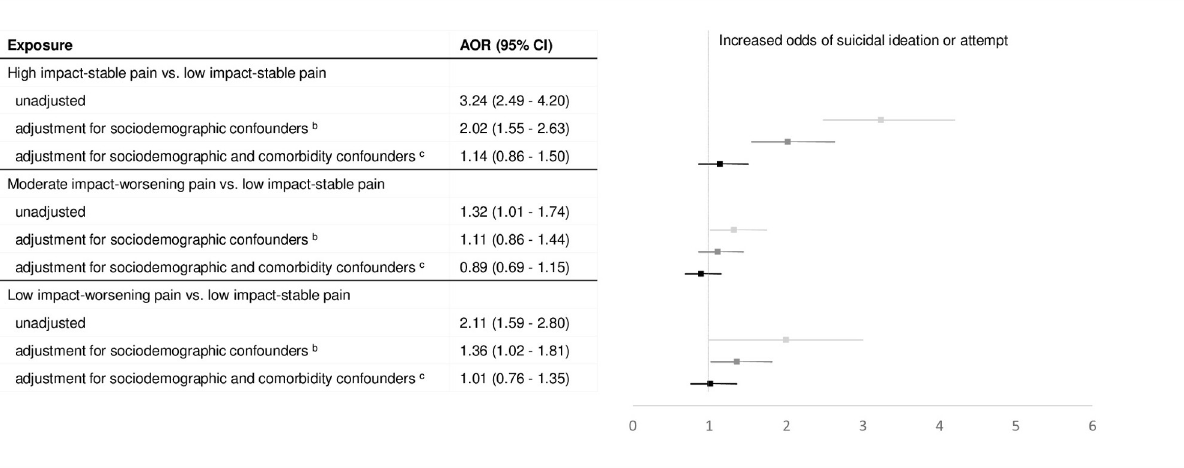
Fig 1. Effects of pain phenotypes on suicidal ideation or attempt a . a Forest plot of odds ratios and 95% confidence intervals associated with pain phenotypes derived from logistic regression analyses: unadjusted, adjusting away confounding associated with short set of covariates using IPSW, and adjusting away confounding associated with long set of covariates using IPSW. b The short set covariates includes sociodemographic characteristics (excludes comorbid health conditions) as predictors. c The long set covariates includes all covariates sociodemographic characteristics and comorbidities.